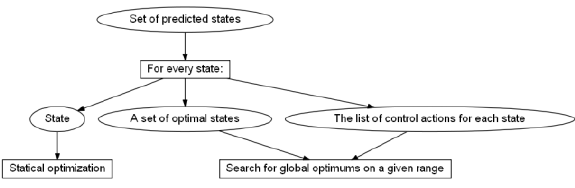
Fig. 13. Structure of dynamic optimization